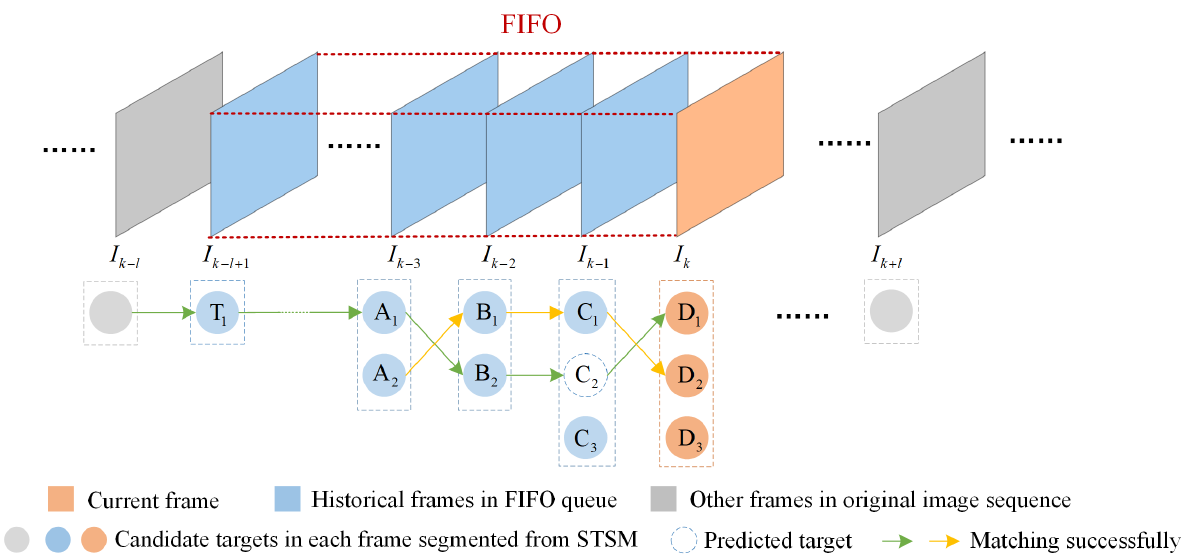
Figure 6. Illustration for LTC measure. Lines of the same color with an arrow mean that candidate targets in adjacent frames are matched